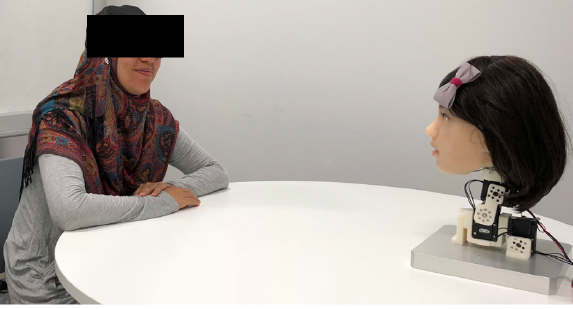
Figure 3: Participant interacts with the EveR-4 (“EveR”) robot.